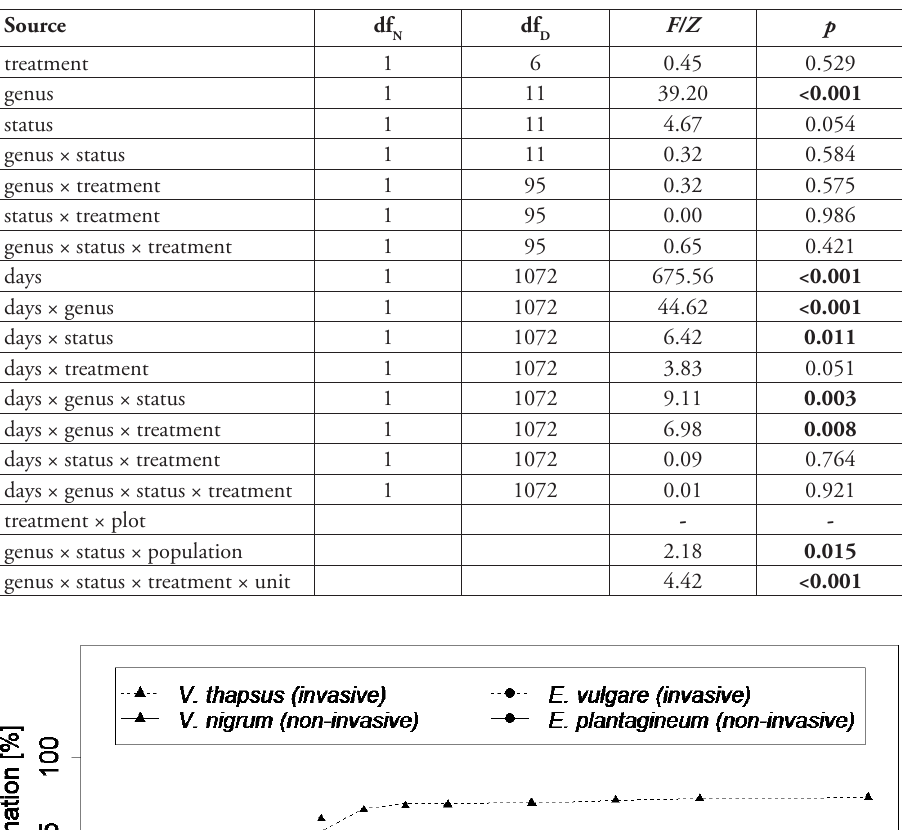
Table 2. Results of the repeated measures analysis of the among-species approach testing for pre-adap- ( p ) are given. ‘Treatment × plot’, ‘genus × status × population’ and ‘genus × status × treatment × unit’ interactions were considered random effects and a Z-value instead of F-value is provided. Bold numbers indicate significant p-values ( p < 0.05).